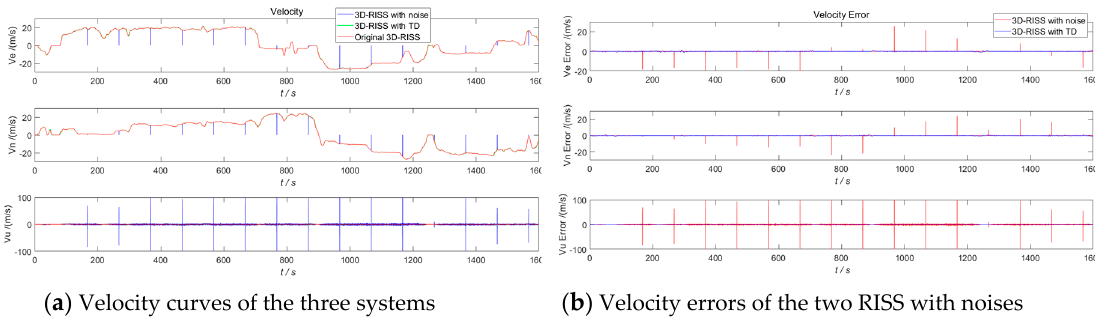
Figure 10. RISS velocity and velocity errors with a noisy odometer velocity filtered by TD.